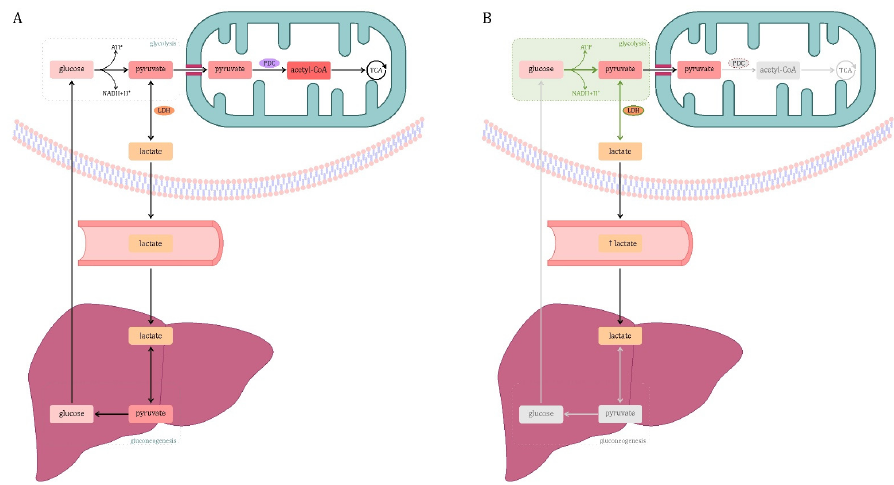
Figure 3. Glucose metabolism. ( A ) Physiological conditions. Glycolysis is the conversion of glucose into pyruvate. In some cases, for example, when glycolysis occurs anaerobically or in cells incapable of pyruvate oxidation, pyruvate may be converted to lactate by the enzyme lactate dehydrogenase (LDH). Blood lactate (mainly formed in skeletal muscle) is taken up by the liver, converted to pyruvate and incorporated into the gluconeogenesis pathway (Cori cycle). In other cases, the pyruvate formed in the cytosol is transported to the mitochondria by a proton symporter. In the mitochondrion, pyruvate undergoes oxidative decarboxylation to acetyl-CoA mediated by the multi-enzyme pyruvate dehydrogenase complex (PDC). Oxidation of pyruvate to acetyl-CoA connects glycolysis with the tricarboxylic acid (TCA) cycle [74]. ( B ) Sepsis. This is due, inter alia, to a decrease in pyruvate dehydrogenase complex (PDC) activity. One explanation is the phosphorylation of the enzyme by pyruvate dehydrogenase kinases (PDKs) and its decreased expression in sepsis. Moreover, in sepsis, the hypoxia-inducible factor 1 α (HIF-1 α ) is activated, which is one of the main mediators of glycolysis. HIF-1 α regulates the expression of genes of enzymes related to glycolysis (hexokinase, phosphofructokinase-1, glucose-6-phosphate dehydrogenase, lactate dehydrogenase, pyruvate dehydrogenase kinase, glutamate transporter-1). The intensification of glycolysis in combination with the failure of entering pyruvate to the tricarboxylic acid (TCA) cycle increases the formation of lactate. A decrease in hepatic lactate-based gluconeogenesis has been reported. This increases the production of lactate, while blocking the main routes of its disposal, which results in an increase in its concentration in the blood. Legend: gray color—inefficient cellular processes; green color—increasing the activity of the process or enzyme.